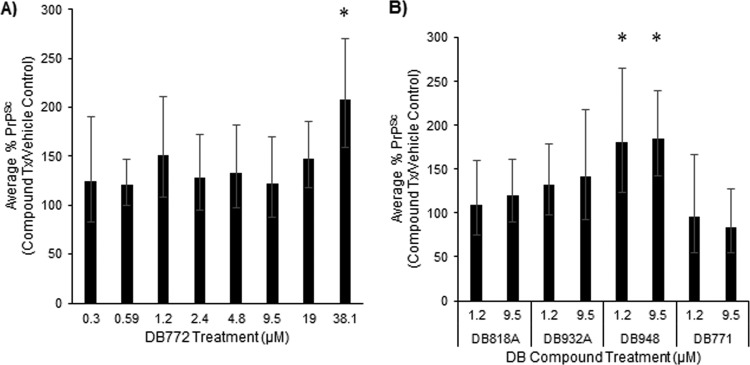
DB772 and DB948 stabilize PrPSc to reduce PK digestion. The stabilization of PrPSc and subsequent reduction in PK digestion by selected compounds were evaluated by treating scrapie-positive sheep brain homogenate with the indicated concentration and DB compound. Aliquots of brain homogenate were treated with the indicated dilutions of DB772 (A) or selected DB compounds (B) and tested for PK-resistant PrPSc by immunoblotting. Band intensities were quantified as described above and normalized to the vehicle control. Columns and error bars represent the mean relative percent PrPSc and 95% confidence intervals, respectively, from at least 5 independent experiments. Mean values were statistically compared to the vehicle control using individual t tests (*, P < 0.05).